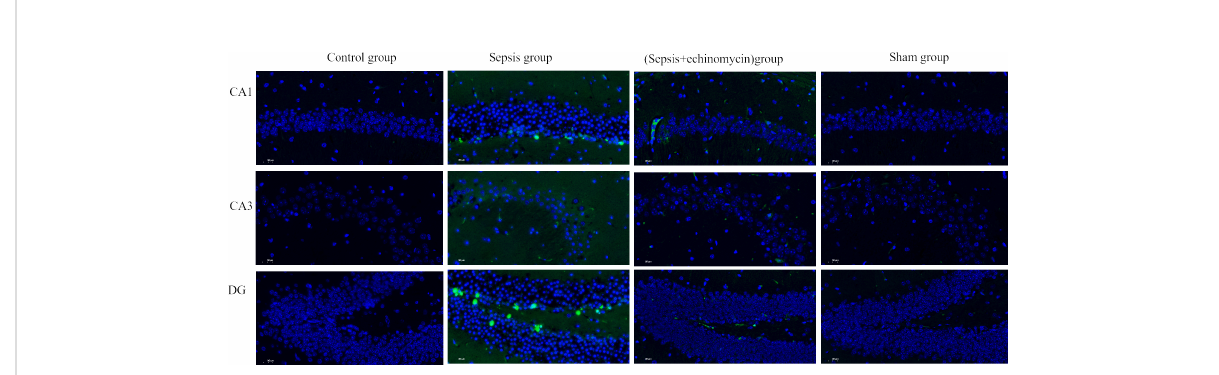
FIGURE 8 HIF-1 a and BNIP3L pathway may induce SAE by promoting apoptosis of hippocampus neurons. Sepsis induce apoptosis of hippocampus